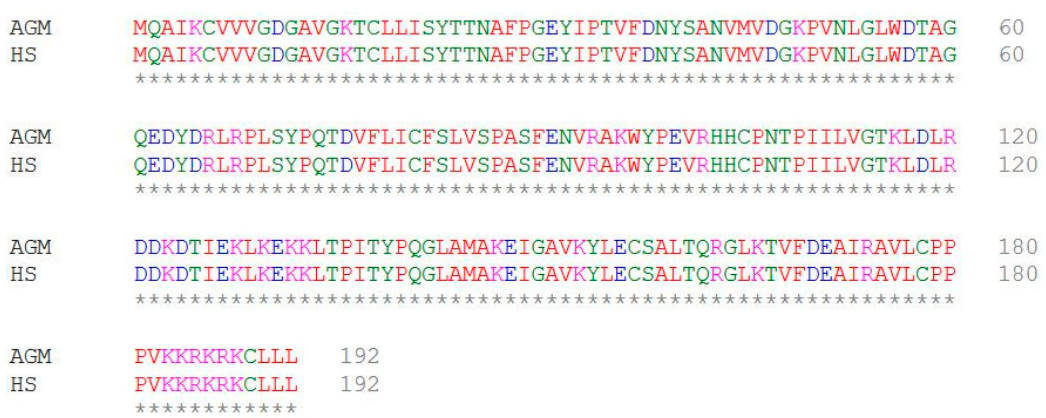
Figure 7. The amino acid sequence alignment of human Rac1 and African green monkey Rac1.